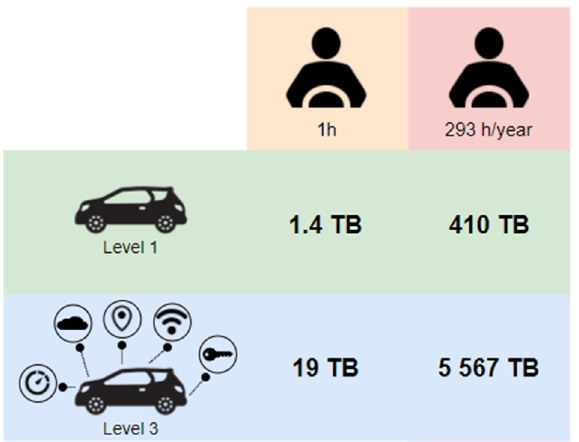
Figure 1. Comparison of total vehicle data production by autonomy level according to [8].